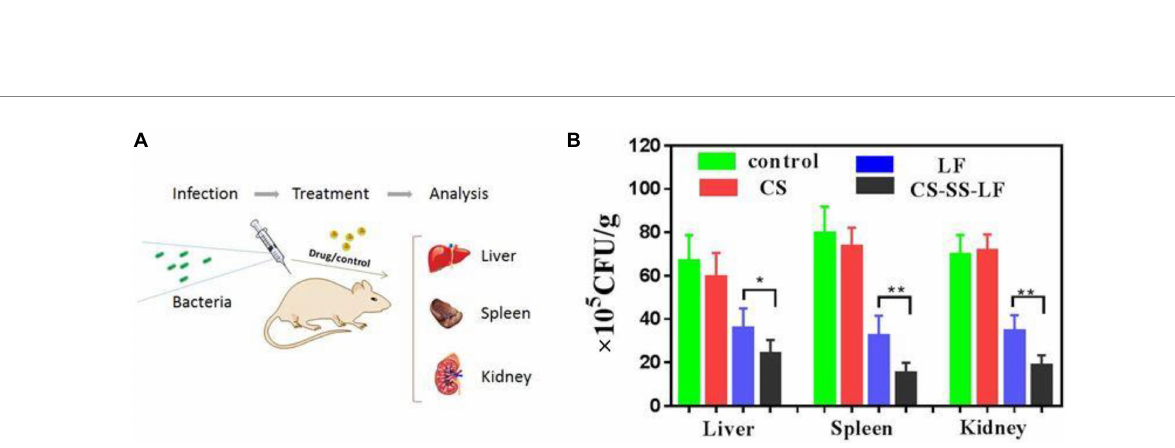
FIGURE 10 (A) An illustration of the in vivo experimental design based on a model of acute infection. (B) A statistical chart of the number of bacteria in the spleen, liver and kidney under CS-SS-LF treatment and control group treatment. (* p < 0.05; ** p < 0.01; *** p <